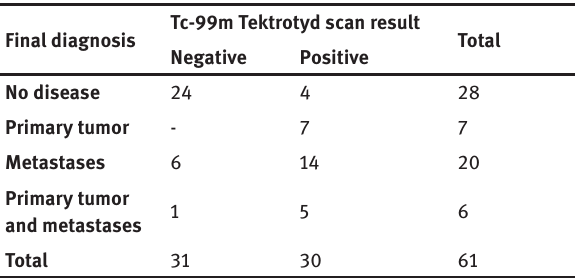
Table 2: Comparison of Tc-99m-Tektrotyd scan results with the final